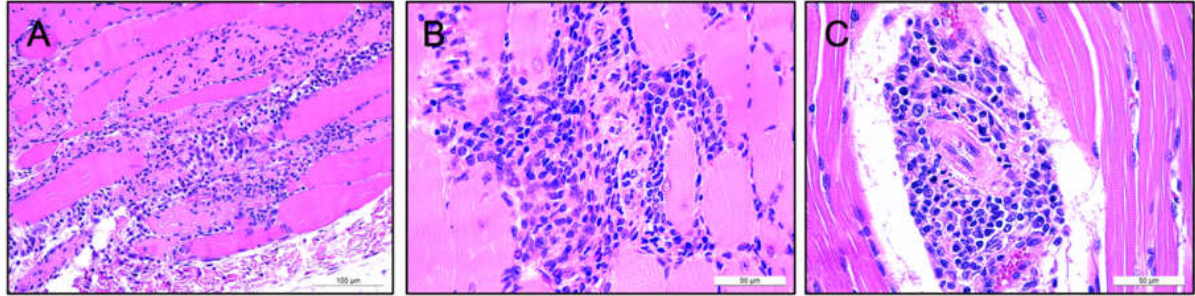
Figure 4. Comparison of striated murine and ovine muscle tissue using H&E staining. Histopathological images of inflamed murine muscle tissue 28 days post IM administered of 5 × 10 12 VG/kg of AAV-31C2 at 20× ( A ) and 40× ( B ), showing lymphocytes and macrophages in the endomysium surrounding numerous myofibers. Straited muscle tissue from Sheep #8486 28 days post IM administered of 5 × 10 12 VG/kg of AAV-31C2 is seen at 40× ( C ). Scattered lymphocytes, plasma cells and rare macrophages were present surrounding myofibers, with accumulation seen in the endomysium and medium-size vessels.